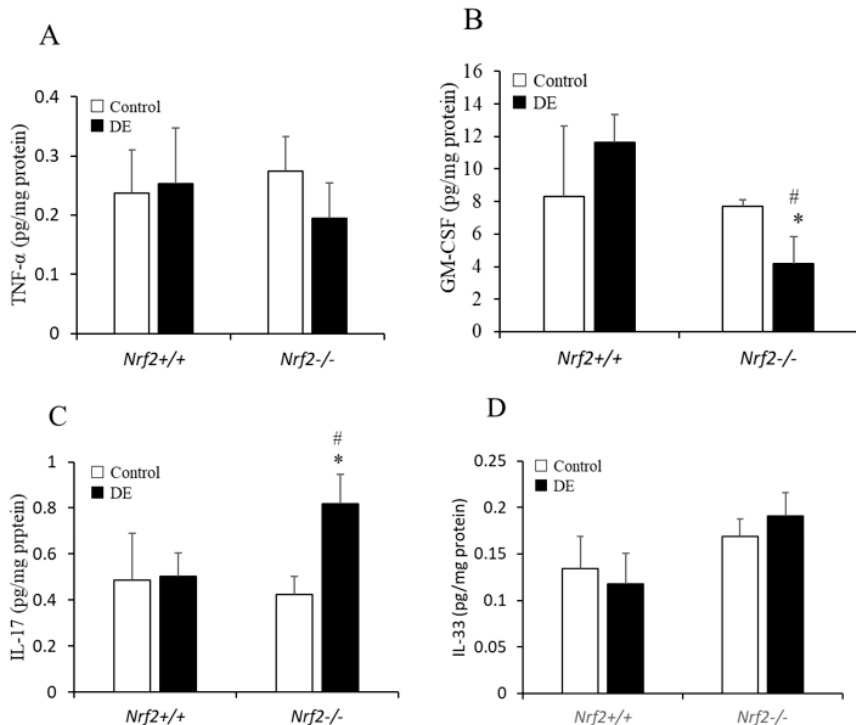
Figure 5. TNF- α ( A ), GM-CSF ( B ), IL-17 ( C ), and IL-33 ( D ) levels in lung tissue supernatants were analyzed using ELISA. Total protein concentrations in the supernatants were measured to normalize the concentration levels of target cytokines in the supernatants. The vertical axis shows percent changes in the cytokines of the DE group relative to the control group. Data are shown as mean ± SD values in each group ( n = 5). * p < 0.05 vs. control; # p < 0.05 vs. Nrf2 +/+ .